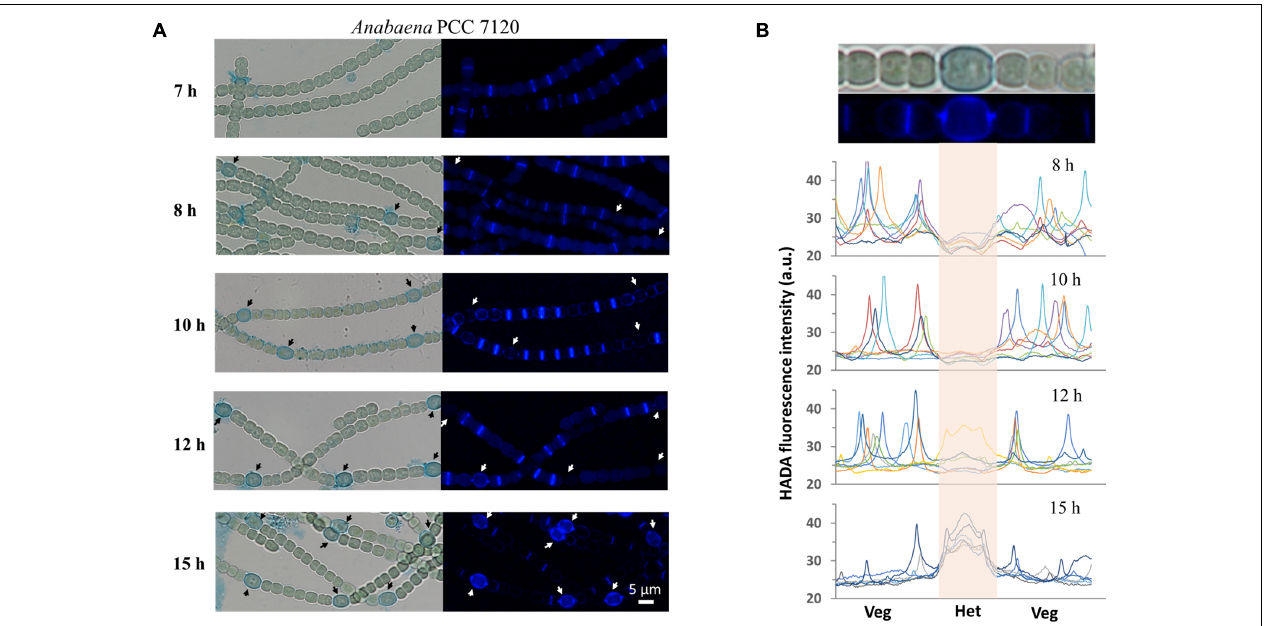
FIGURE 6 | Determination of the timing of PG synthesis in heterocysts. Hetercoysts differentiation takes approximately 20–24 h after the deprivation of combined nitrogen from the growth medium. Heterocysts were induced in the BG11 0 medium containing 200 µ M HADA. Seven hours after the induction, filaments were stained with Alcian blue which binds to heterocyst-specific polysaccharide layer, to better recognize the developing cells (arrows). (A) The filaments were examined under both bright-field and for HADA fluorescence to determine the incorporation of HADA into developing heterocysts. The same procedure was followed after 10 h, 12 h and 15 h of induction. All HADA fluorescence images were taken using the same exposure time (1 s) and were processed with the same procedures using ImageJ. (B) Quantification of HADA incorporation in developing and mature heterocysts at 8 h, 10 h, 12 h, and 15 h. At each time point, the fluorescence signal along seven representative short filaments, each of which consists of one heterocyst (Het) at the center and a few vegetative cells (Veg) on each side, were quantified with ImageJ. Every curve in the graphs represents the fluorescence intensity along one filament. The signal from developing or mature heterocysts in the graphs is indicated by the center shadow area. The bright-field microscopy image and the HADA fluorescence picture of one filament from the 15 h sample were shown at the top of the panel for illustration